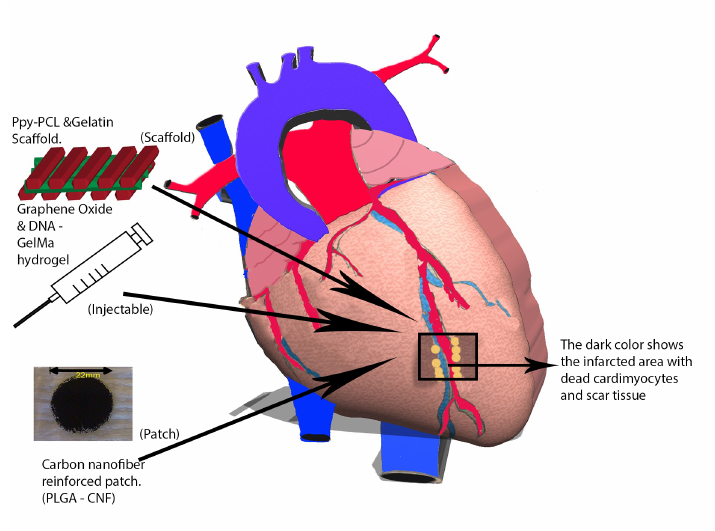
Figure 1. During a myocardial infarction, blood flow is deprived to the myocardium, which, in turn, injures the tissues downstream of the obstruction. As a result, cardiomyocytes are deprived of oxygen and eventually perish. Next, myofibroblasts migrate towards this infarct area and ultimately create scar tissue that reduces the heart’s contractile ability and weakens it. The weakened area is unable to withstand the pressure and volume load on the heart, thereby causing left ventricular dilation. Over time, this scar tissue causes ongoing remodeling, and the heart becomes more spherical, thus impairing systolic and diastolic function. To combat the progress of cardiovascular disease (CVD) and ventricular remodeling, modern research has deployed the use of nanomaterials through the use of scaffolds, patches, and injectable materials for regenerating the heart